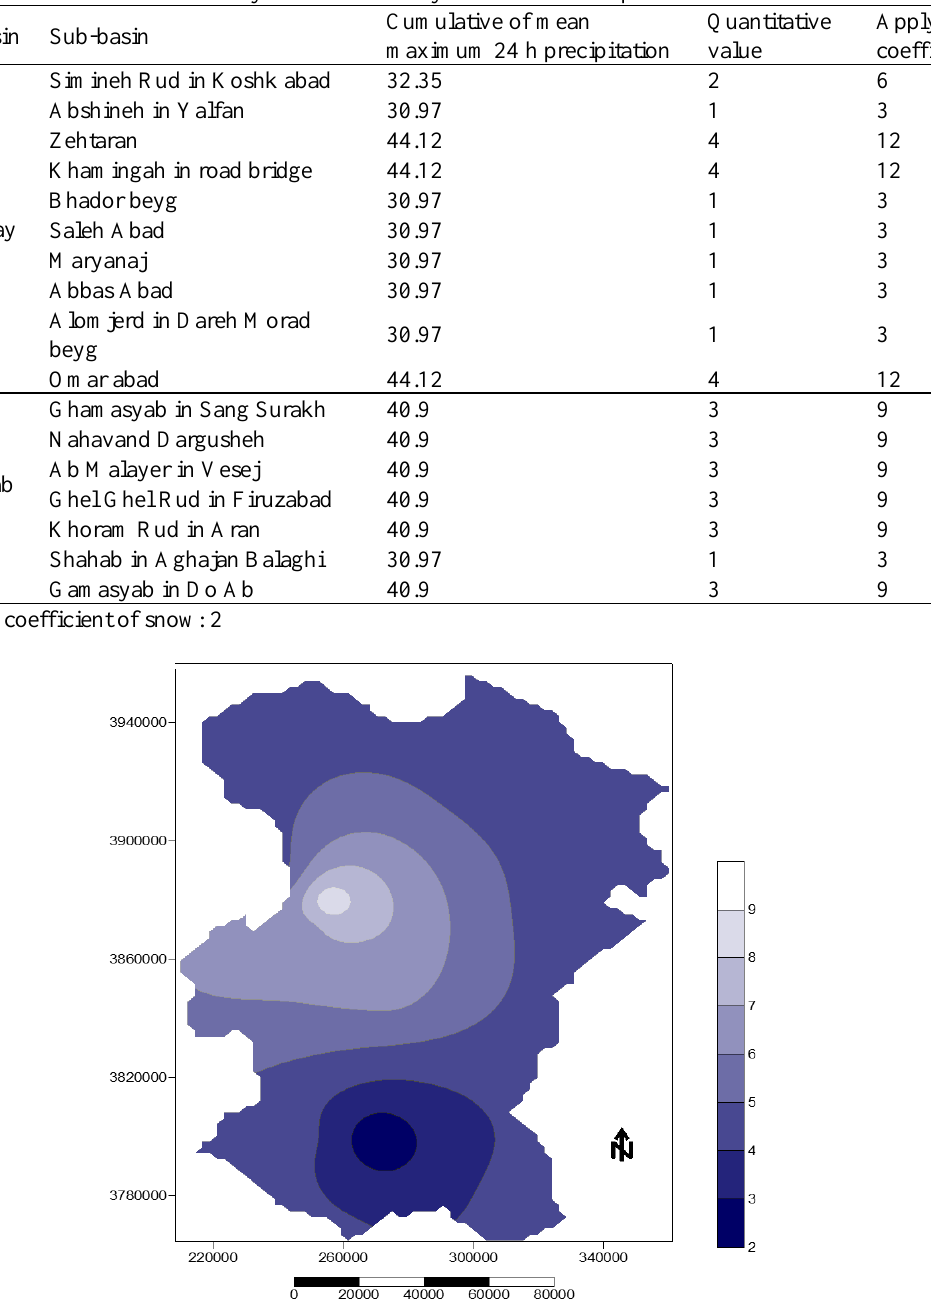
Table 2. Amount of snow in Gamasyab and Gharechay sub-basins with quantitative value Main basin Sub-basin